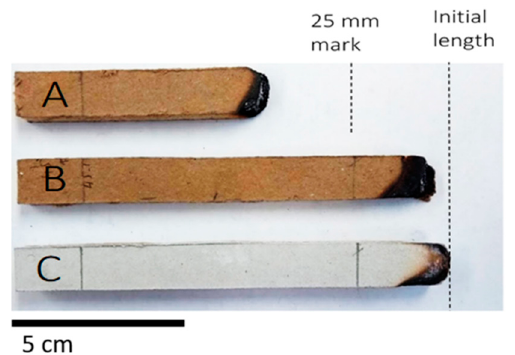
Figure 10. Burning characteristics of ( A ) untreated, ( B ) treated with 5% boric acid / borax, and ( C ) commercial gypsum board.